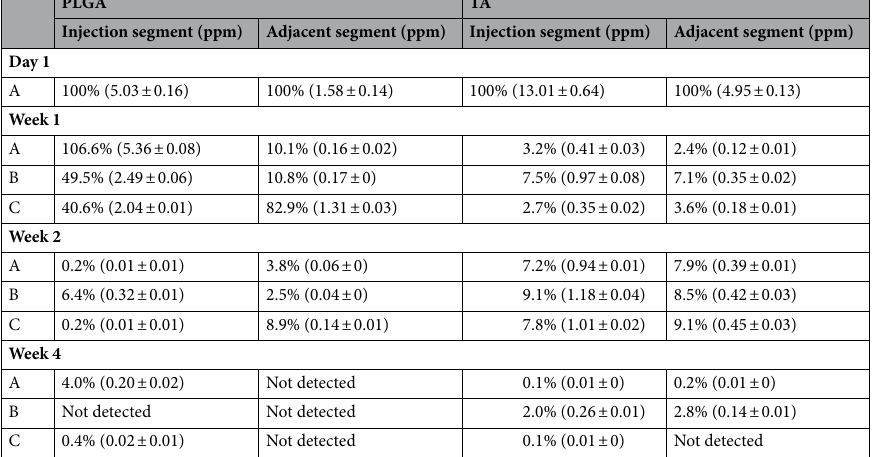
Table 1. Residual steroid concentration (RSC) in the extracted spinal segments according to the time-points, drug formulations, and locations. Table 1 presents the raw data of the study results. Values are expressed as mean ± standard deviation, because each sample was analyzed three times for accuracy. To intuitively compare RSCs, the values obtained from animals in each group sacrificed immediately after ESI (Day 1) were used as standard (set 100%, relatively). RSC residual steroid concentration, PLGA poly (lactic-co-glycolic acid), TA triamcinolone acetonide, ESI epidural steroid